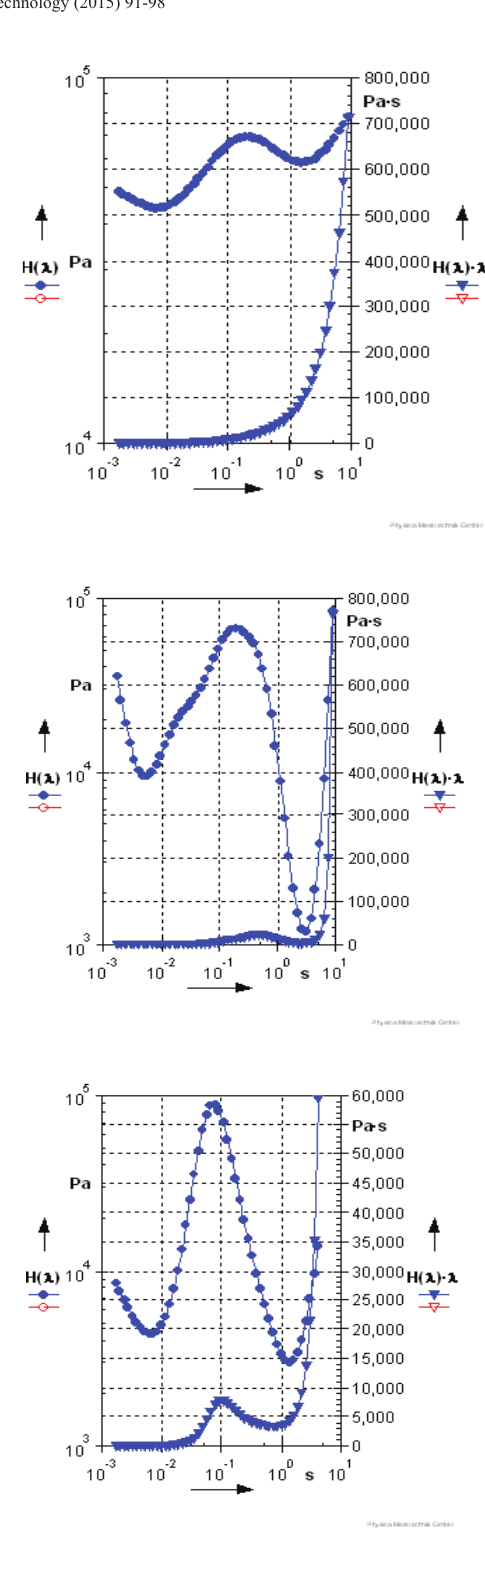
Figure. 7. Relaxation time distribution, H(λ) of samples S 2, S3 and